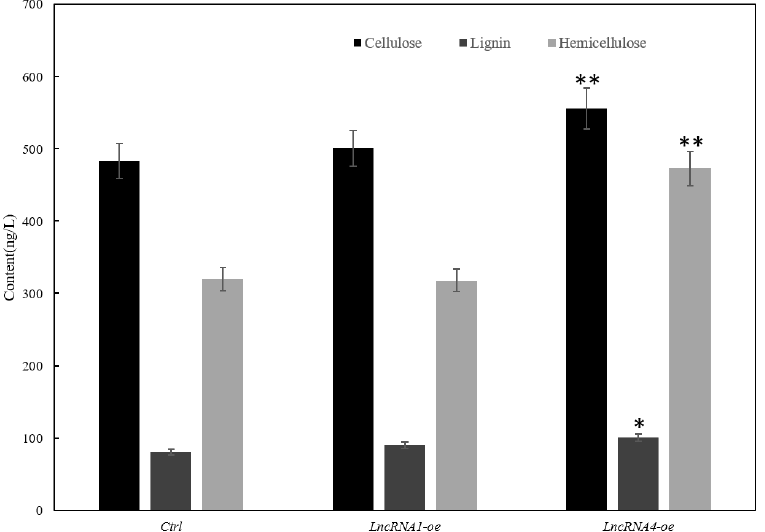
Figure 6. Component content of overexpression and wild type 84K poplar trees. Bars represented standard errors (SE), * represented the significant difference ( p < 0.05), and ** represented the highly significant difference ( p < 0.01). Values were reported as means ±SE ( n = 4).